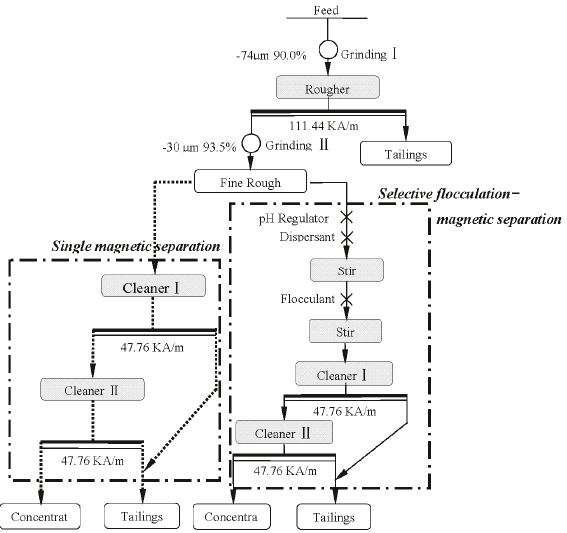
Figure 2. The flow-sheet of process.